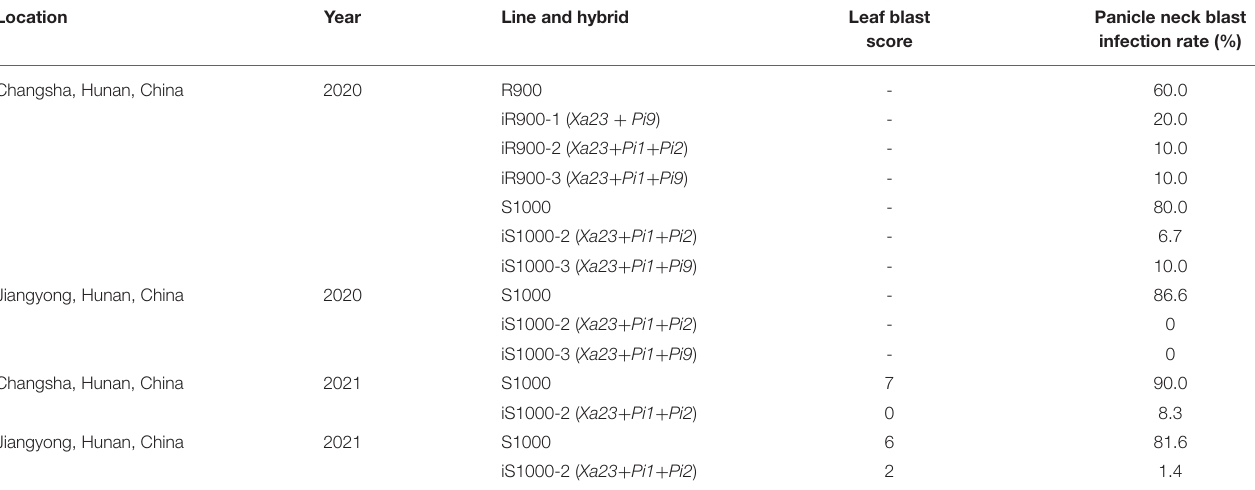
TABLE 3 | Performance of leaf and panicle neck blast resistances of the iR900 and iS1000 hybrids in natural blast nurseries. Location Year Line and